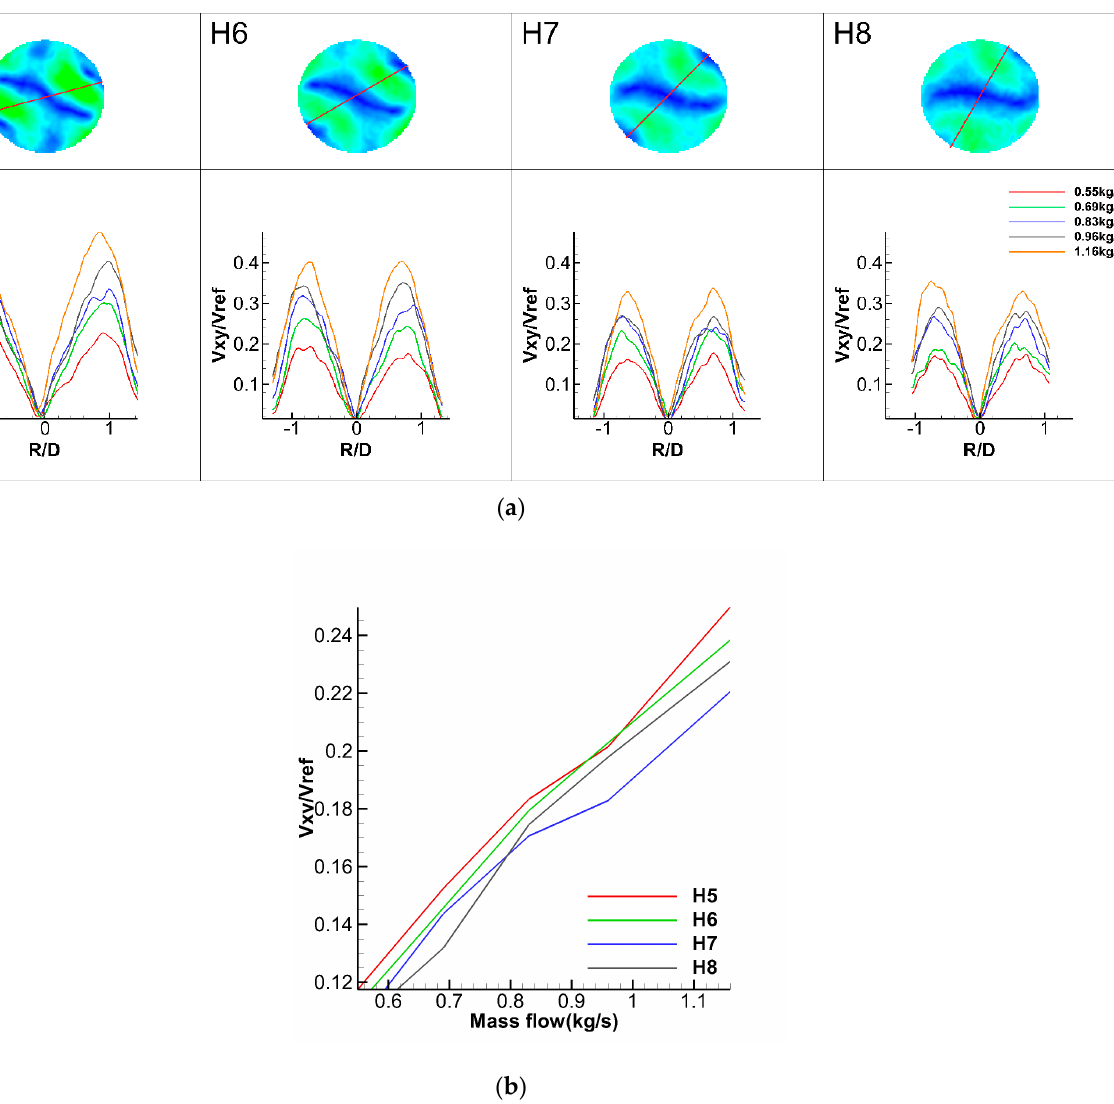
Figure 14. Self-similarity of cross-sections. ( a ) Velocity on a selected diameter for each working condition. ( b ) Average velocity-Mass Flow Rate.